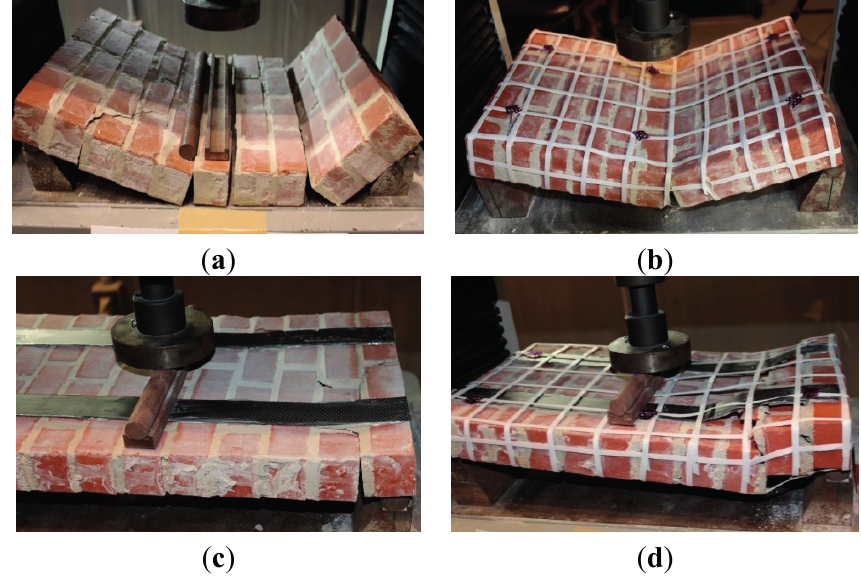
Figure 8. Failure mode and cracking pattern of Type-2 masonry panels under out-of-plane bending test for ( a ) URM, ( b ) PP-band retrofitted, ( c ) CFRP retrofitted, and ( d ) CFRP + PP-band